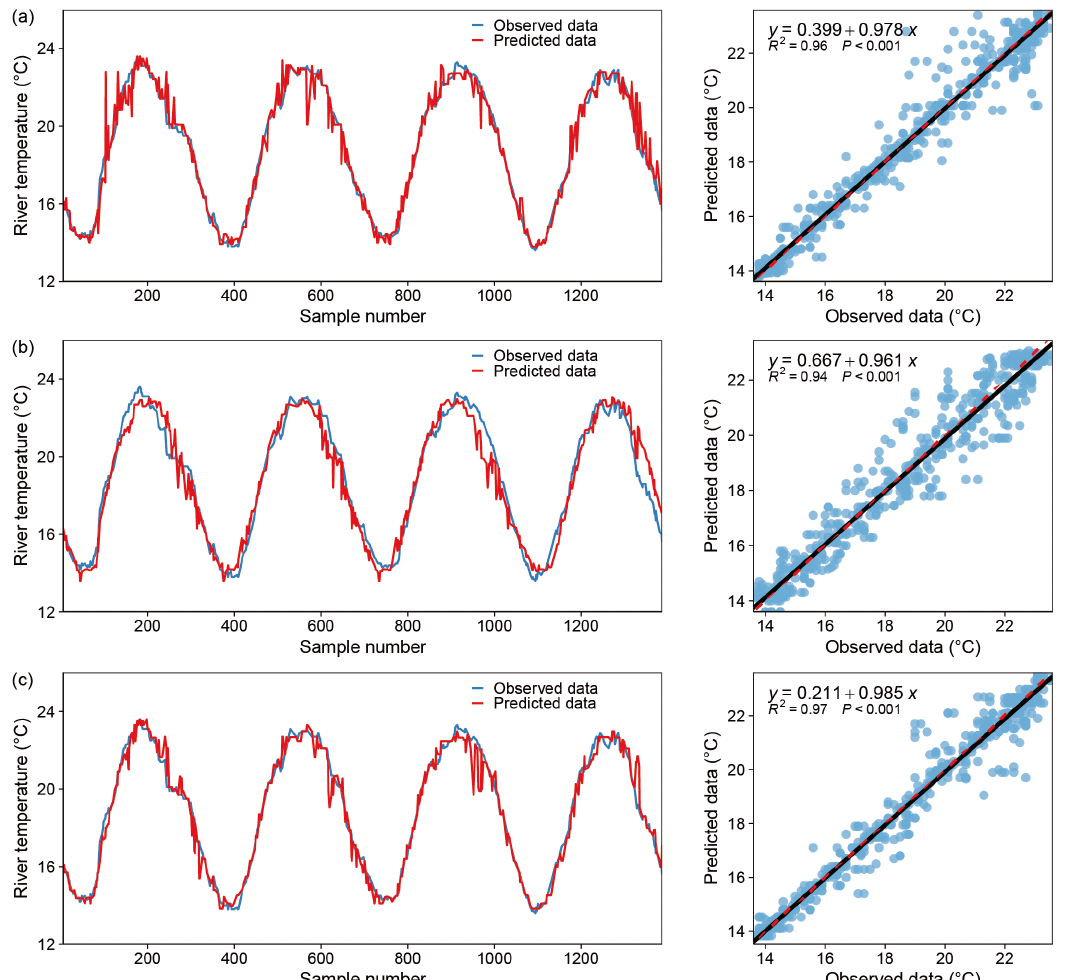
Figure 7. Model fitting results—DecisionTree Regressor, blue dot: X coordinate (observed data), Y coordinate (predicted data) ; black line: y = x ; red dotted line: the regression curve of the blue dots. ( a ) only one input variable (DOY), ( b ) two input variables (DOY and Flow), ( c ) all